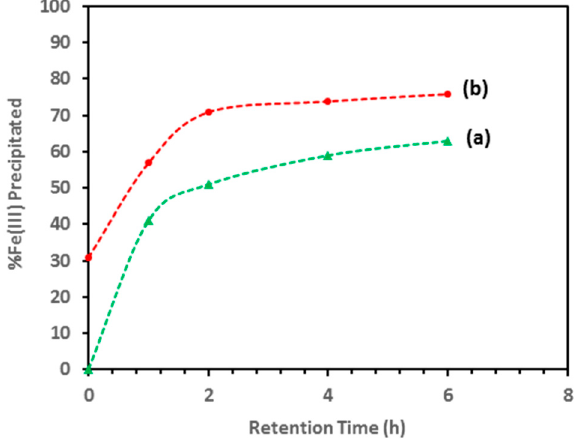
Figure A2. E ff ect of retention time on Fe(III) precipitation from solutions containing 6 g / L Fe(III), 15 g / L Figure A2. Effect of retention time on Fe(III) precipitation from solutions containing 6 g/L Fe(III), 15 H 2 SO 4 , 11g / L Cl − , and 30 g / L Cu(II) at 150 ◦ C; ( a ) 0.0 g / L seed; ( b ) 15.0 g / L hematite seed. Data replotted g/L H 2 SO 4 , 11g/L Cl¯, and 30 g/L Cu(II) at 150 °C; ( a ) 0.0 g/L seed; ( b ) 15.0 g/L hematite seed. Data from replotted from [26].